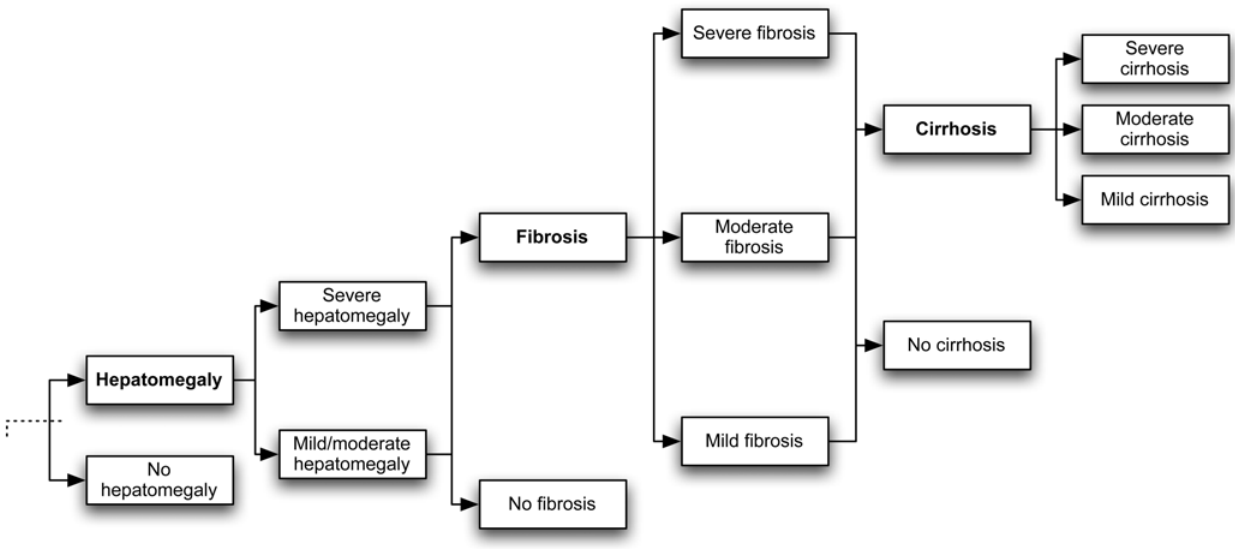
Figure 2. Schematic representation of the model. Shown is the branch of the model depicting liver pathology, which may or may not be present. If present, there may be hepatomegaly of varying degrees. Regardless of the degree of hepatomegaly, fibrosis may exist. Cirrhosis could only occur when fibrosis was present. Other comorbidities did not depend on the presence of other conditions.